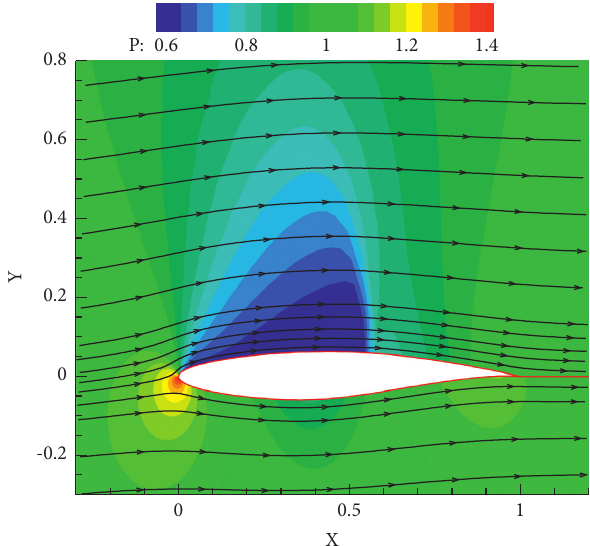
Figure 9: Pressure contours and streamlines with WENO-NZ scheme for RAE2822 airfoil.